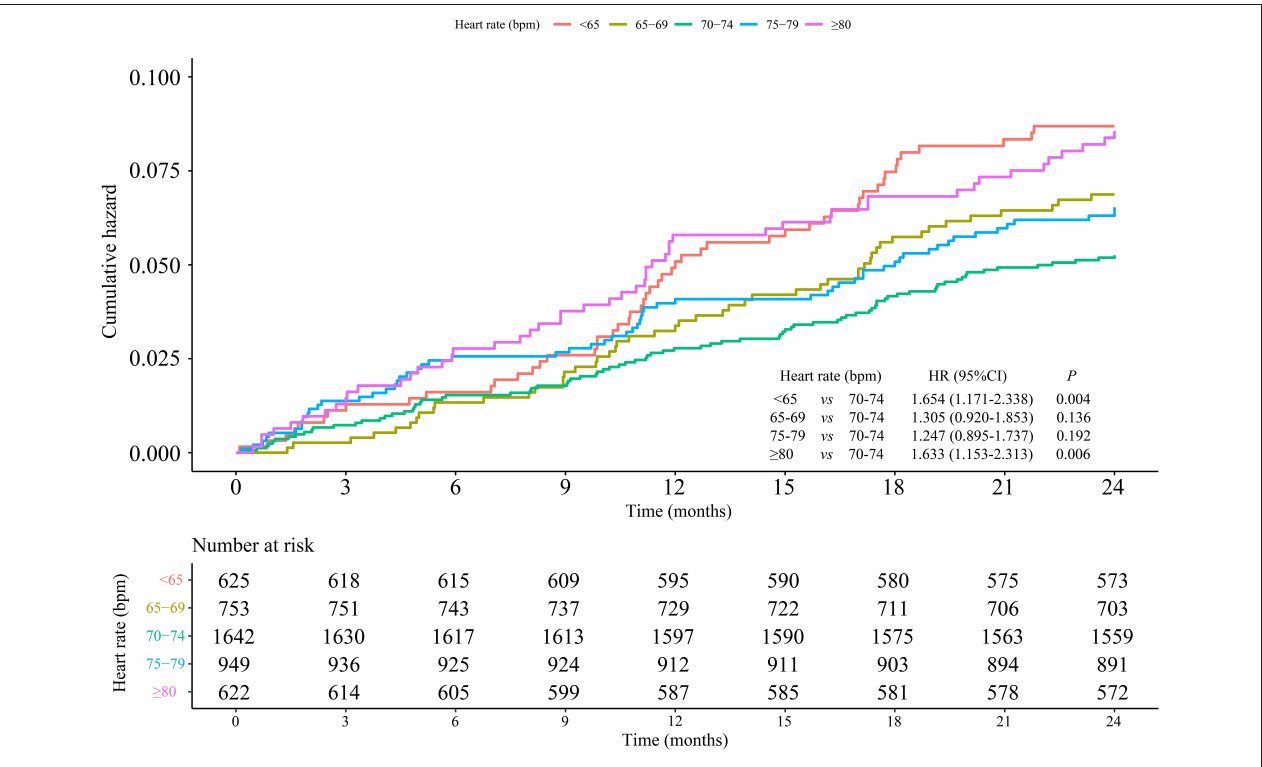
FIGURE 5 | Association between heart rate and MACE risks in hypertensive elderly